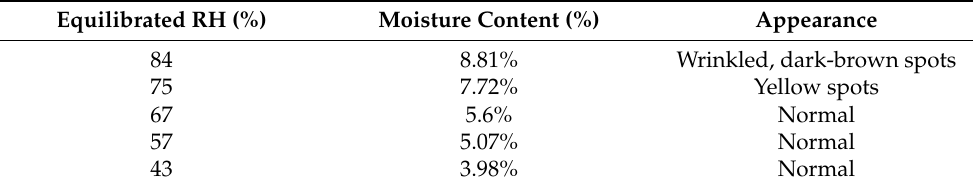
( b ) Genus-level microbial structure; ( c ) NMDS analysis showing similarity among fungal populations from kernels of sunflower seeds exposed to various levels of relative humidity (RH) for six months. Table 2. Moisture contents and appearances of sunflower seed kernels incubated at various relative humidities (RHs).